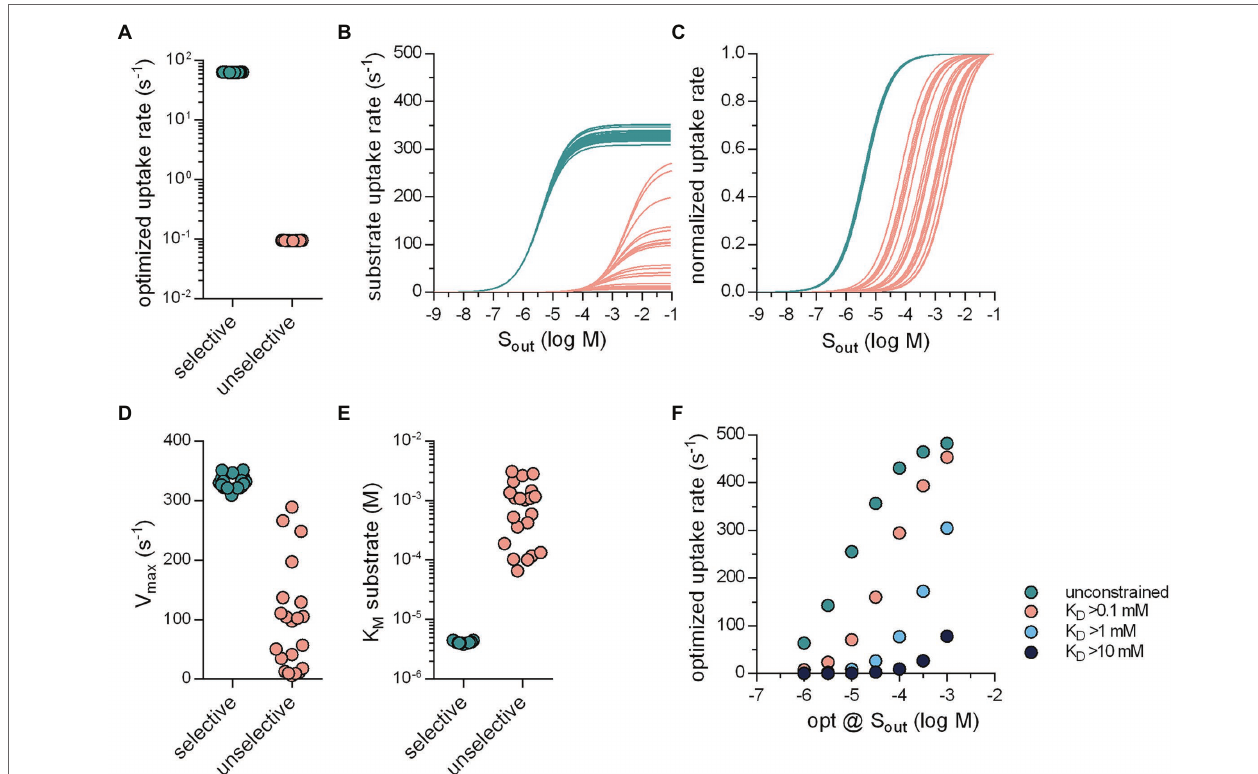
FIGURE 5 | Selective transporters can support larger substrate uptake rates. (A) Optimized substrate uptake rates for selective (green circles; 63.79 ± .19 s − 1 ; n = 20) and unselective transporters (pink circles; .095 ± .0006 s − 1 ; n = 20). The transporters were optimized for 1 μ M S out . The substrate K D of the unselective transporters was not allowed to drop below 10 mM. For the optimizations we used the random binding order scheme. (B) Substrate uptake rate as a function of S out for the selective (green lines) and the unselective transporters (pink lines). (C) The same data as in (B) but normalized (D) V max values of selective and unselective transporters. The coefficient of variation of the V max values was .034 and .91 for selective and unselective transporters, respectively (E) K M values of selective and unselective transporters. The coefficient of variation of the K M values was .042 and .90 for the selective and unselective transporters, respectively. (F) The substrate uptake rate as a function of the concentrations of S out for which these rates were optimized. The green circles are the optimized rates of the selective transporters. The circles in pink, light blue, and dark blue are the optimized rates of unselective transporters, for which the substrate K D was not allowed to drop below .1 mM, 1 mM, and 10 mM, respectively ( n = 10 for each S out ). The optimized rates of the unselective transporters were lower than that of the selective